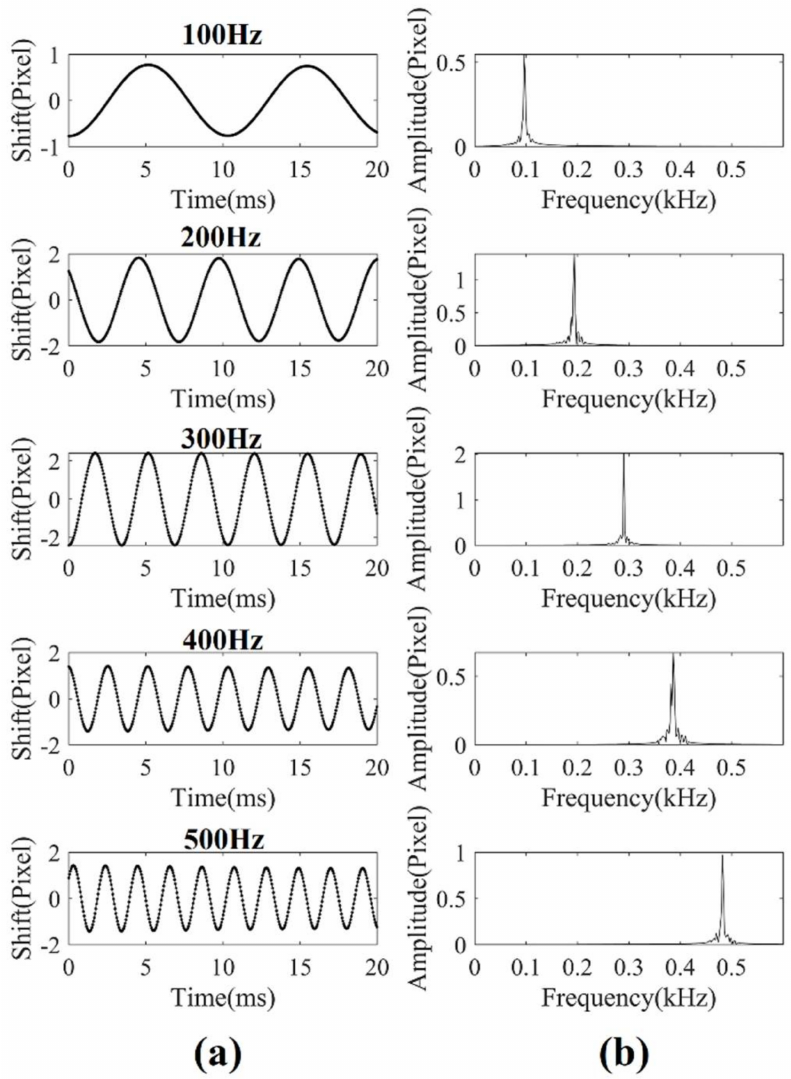
Figure 9. ( a ) Restored waveforms of audio signals at different frequencies. ( b ) Spectrogram of restored signals at different